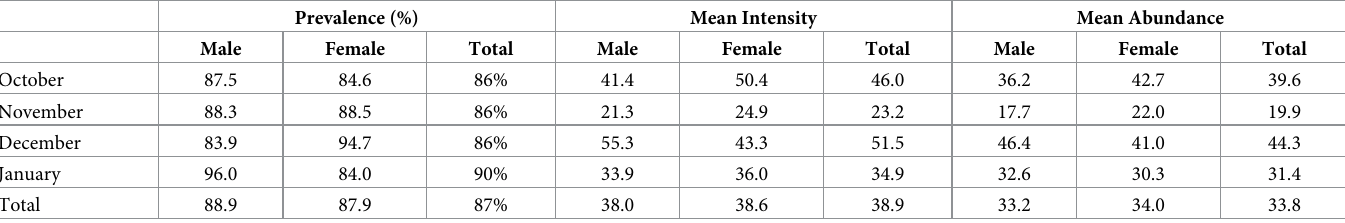
Table 1. Parasitological